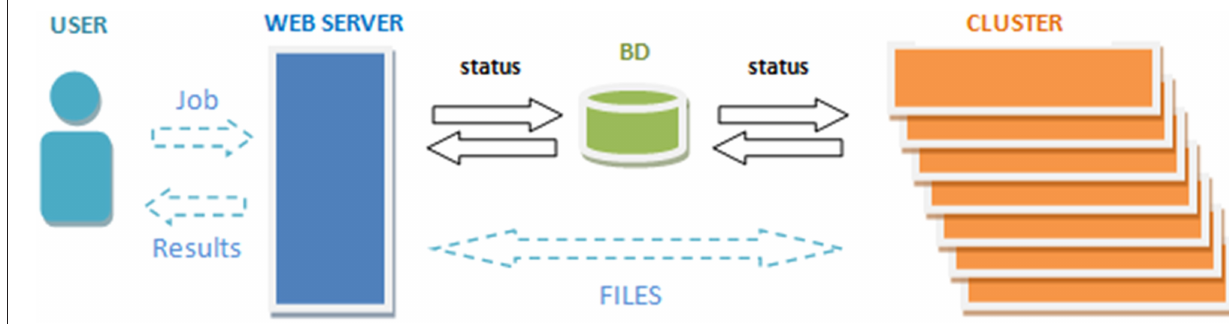
FIGURE 2 | The volBrain system processing scheme.